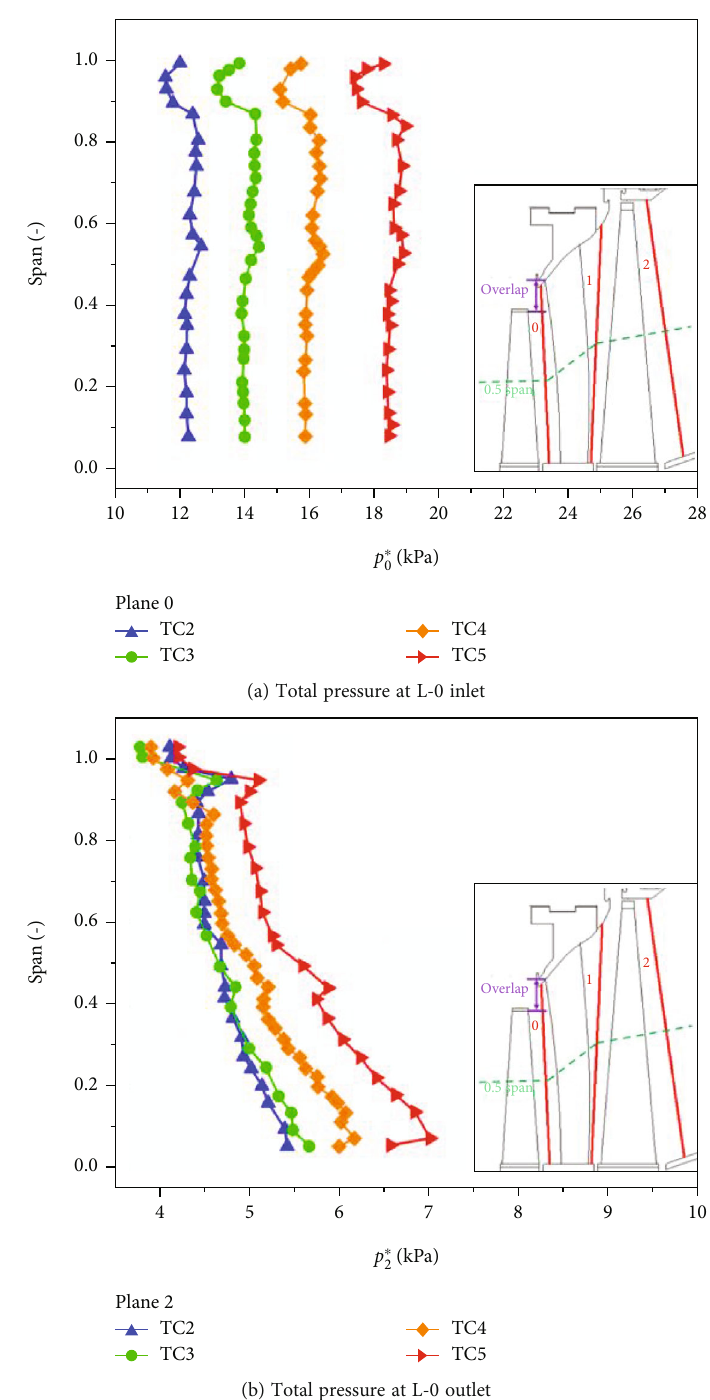
Figure 6: Total pressure distribution at L-0 inlet and outlet from TC2 to